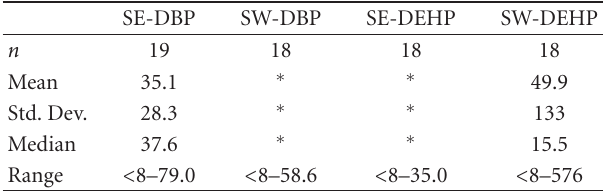
Table 4: Distribution of parent phthalate concentrations in serum (SE) and sweat (SW) ( μ